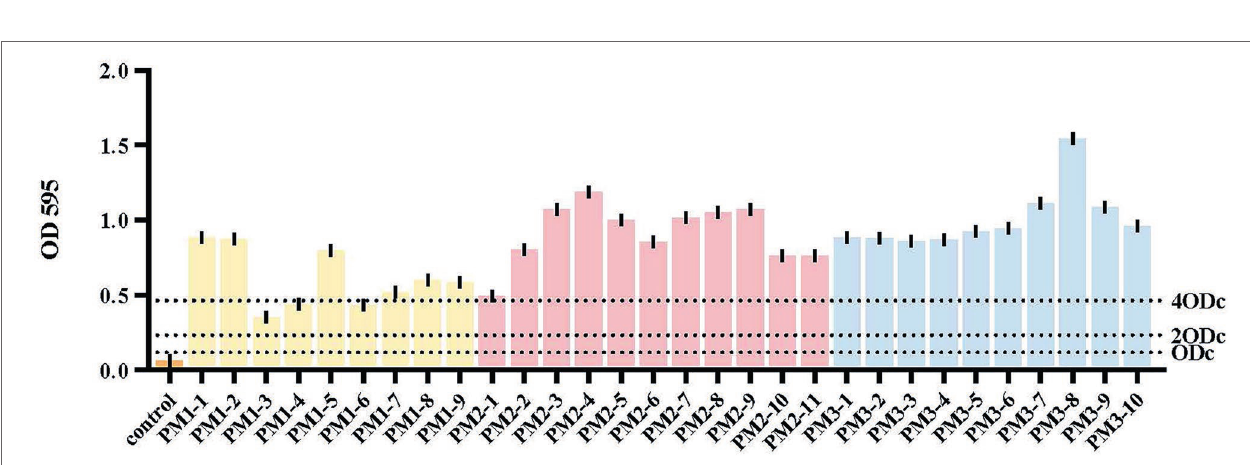
FIGURE 1 | Phylogenetic tree of 31 P. mirabilis isolates in this study. (A) 16S rDNA tree. (B) SNP tree. (C) PCA analysis.